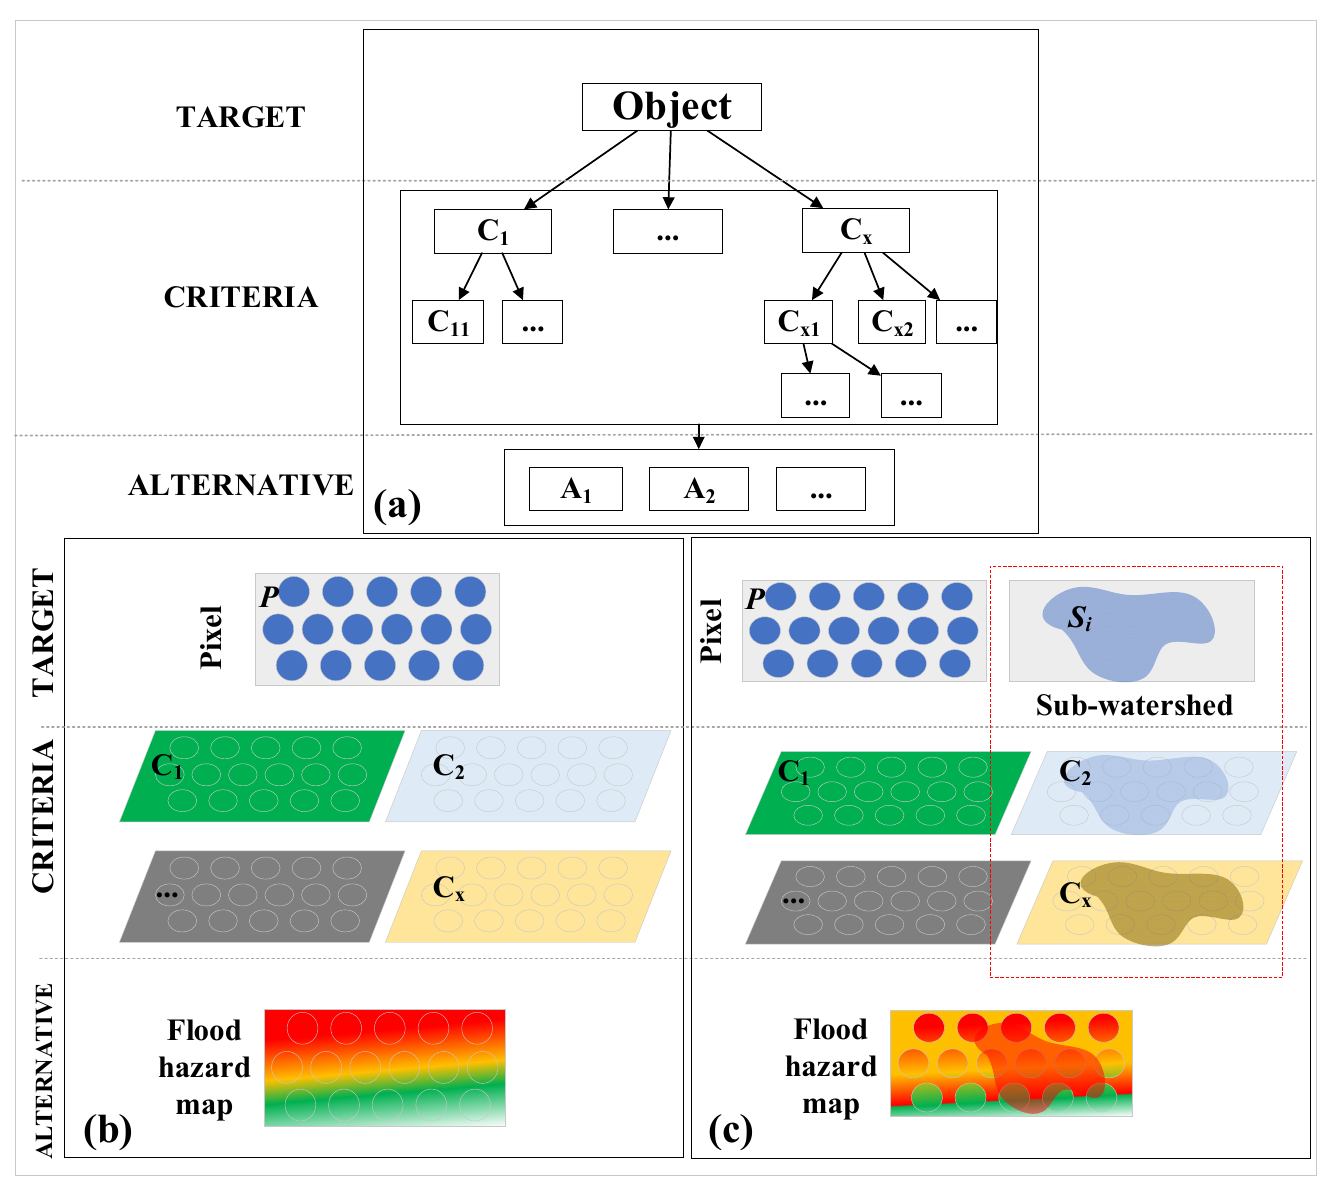
Figure 3. The logical structure of flood hazard estimation methods: ( a ) The general structure of AHP, ( b , c ) are diagrams of ordinary AHP and WZSAHP-RC.